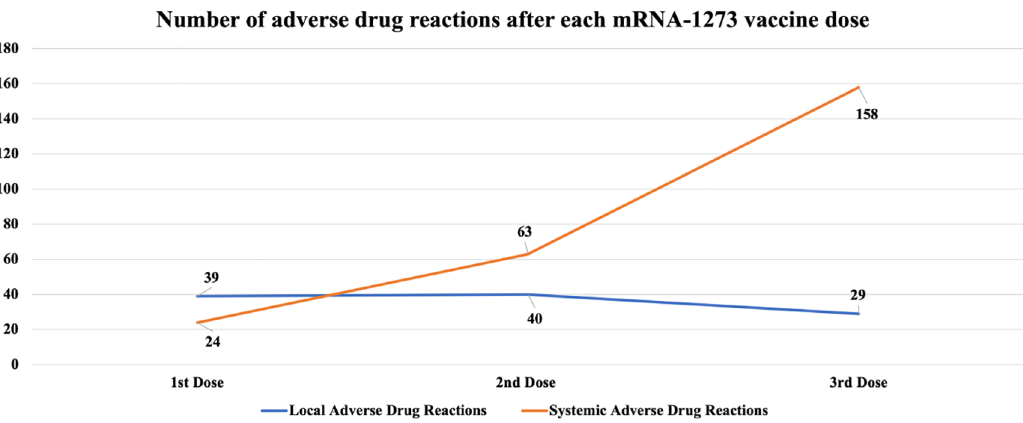
Figure 1. Number of ADRs after each mRNA-1273 vaccine